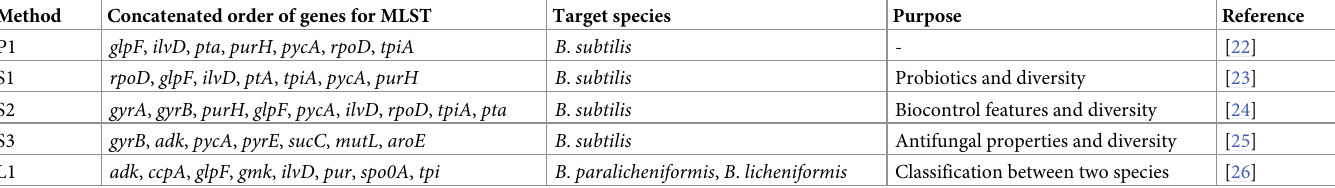
Table 1. Five MLST methods for Bacillus